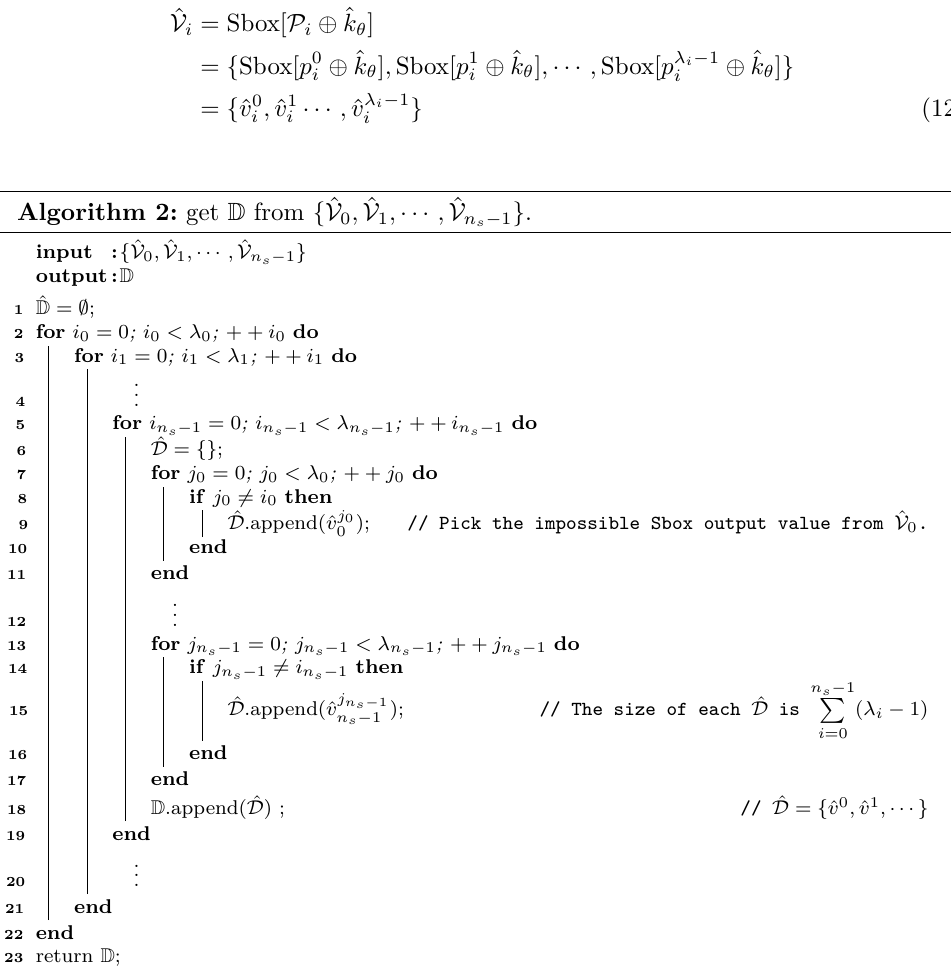
Algorithm 2: get D from {